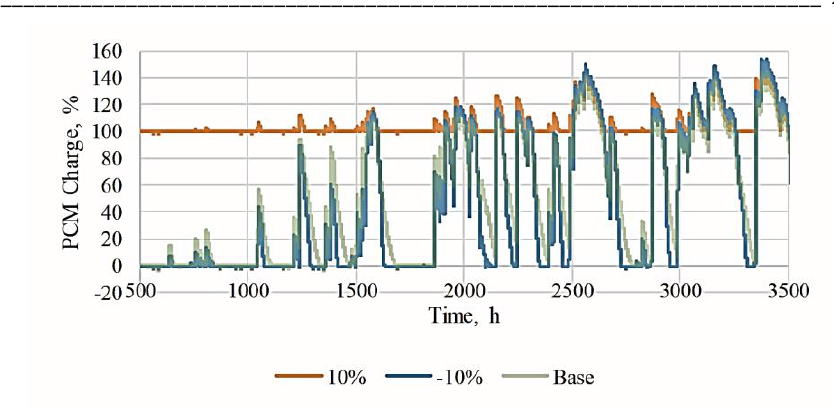
Fig. 9. Minute data for part of the year of PCM charge data for the base case and cases with increased and decreased by 10 % heater setpoint.